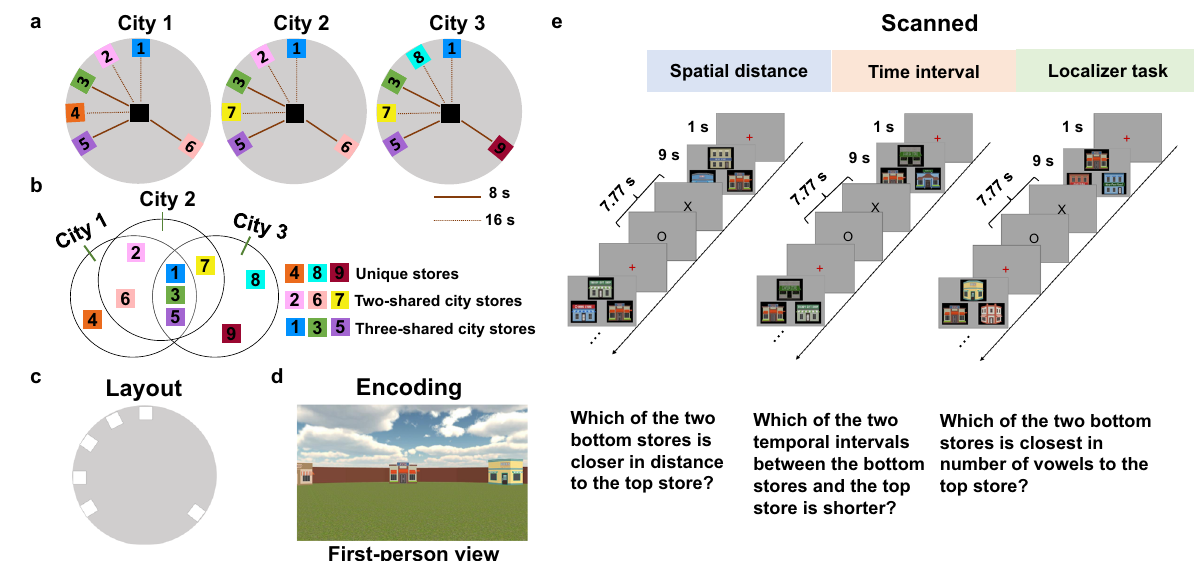
Fig. 1 Schematic of the experimental design. a Layouts for each environment are depicted from a survey view. Each colored box represents a target store (except the center one). Cities 1 and 2 are identical aside from the “ Store 4 ” in City 1, which was changed to “ Store 7 ” in City 2. Cities 2 and 3 were the same except “ Store 2 ” and “ Store 6 ” in City 2 were changed to “ Store 8 ” and “ Store 9 ” in City 3, respectively. The lines from the center store to each peripheral store represent the temporal durations: 8 s (red solid line); 16 s (red dashed line). b Venn diagram depicting the shared stores between the three overlapping environments (note: this does not show physical overlap but rather the stores that are the same between environments). “ Unique city stores ” refers to the stores that only belonged to one city (i.e., “ Store 4 ” , “ Store 8 ” , and “ Store 9 ” ); “ Two shared city stores ” refers to stores that belong to two cities at the same time (i.e., “ Store 2 ” , “ Store 6 ” and “ Store 7 ” ); “ Three shared city stores ” refers to stores that belong to three cities at the same time (i.e., “ Store 1 ” , “ Store 3 ” , and “ Store 5 ” ). c The three environments shared the same physical layout of stores although the identities of stores differed. d An example of an encoding trial from a fi rst-person perspective. Participants encoded the locations of stores and the duration from the center store to peripheral stores. e Retrieval consisted of 6 runs of city-speci fi c spatial distance judgments and 6 runs of city-speci fi c temporal durations judgments. After the retrieval task, participants were asked to complete a localizer task involving a vowel counting